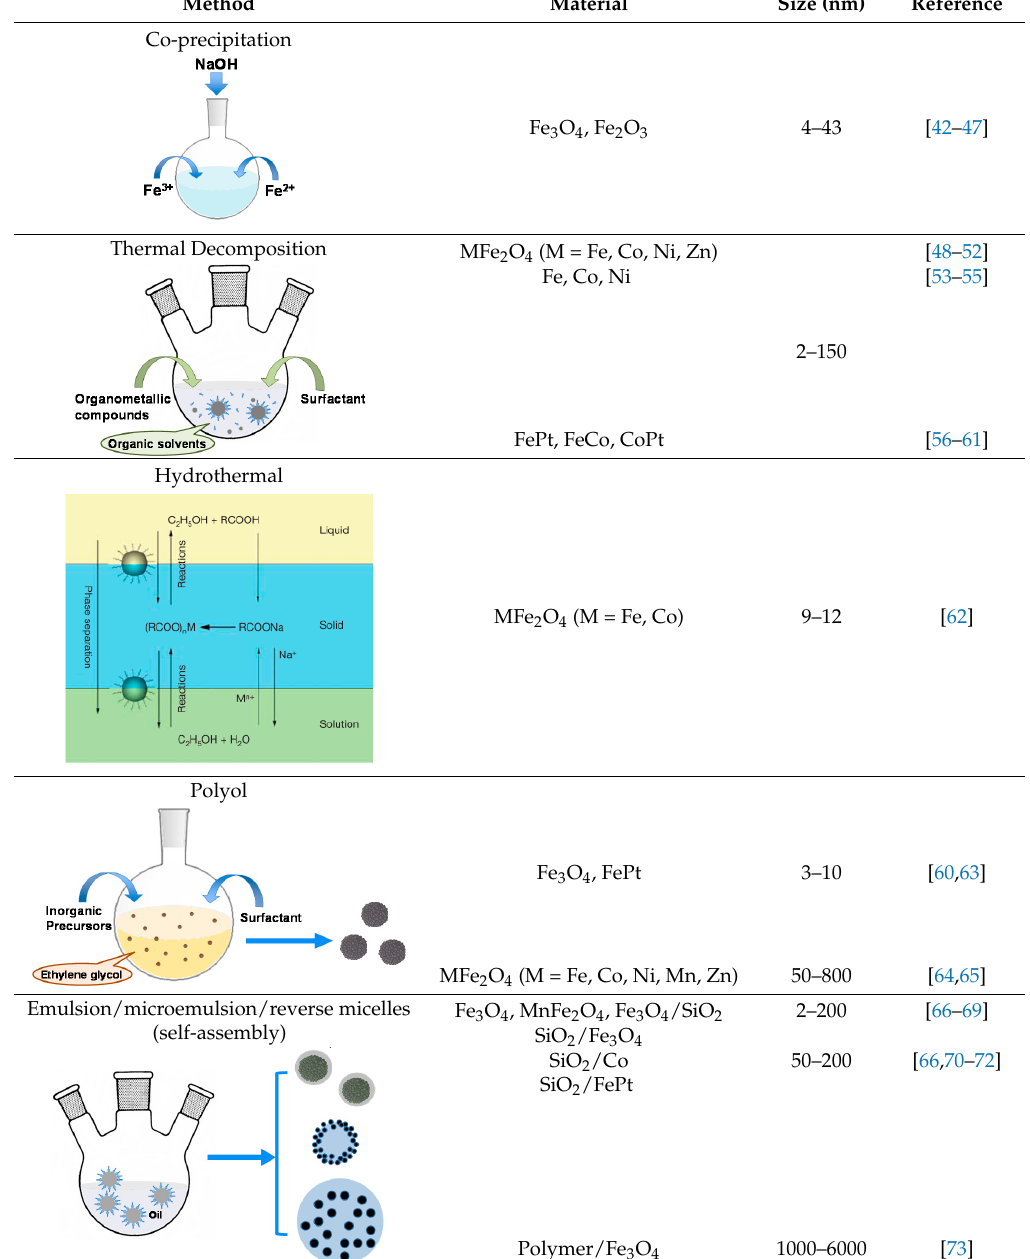
Table 1. General Methods for the Synthesis of Magnetic Particles.